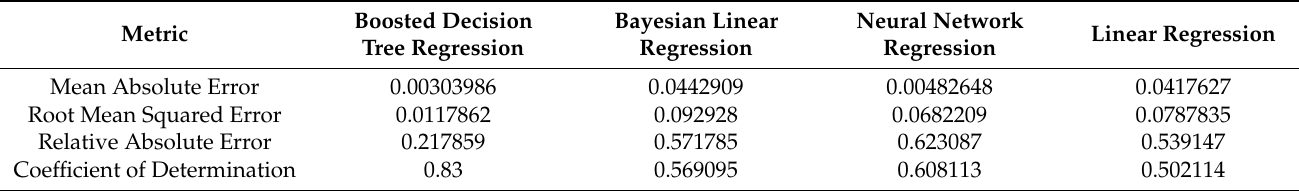
Table 1. Performance evaluation of the regression models in hydrogen storage (wt.%) prediction. Reprinted with permission from Rahnama et al., (15 March 2019) Copyright 2019, Hydrogen Energy Publications LLC. Boosted Decision Bayesian Linear Neural Network Metric Linear Regression Tree Regression Regression Regression Mean Absolute